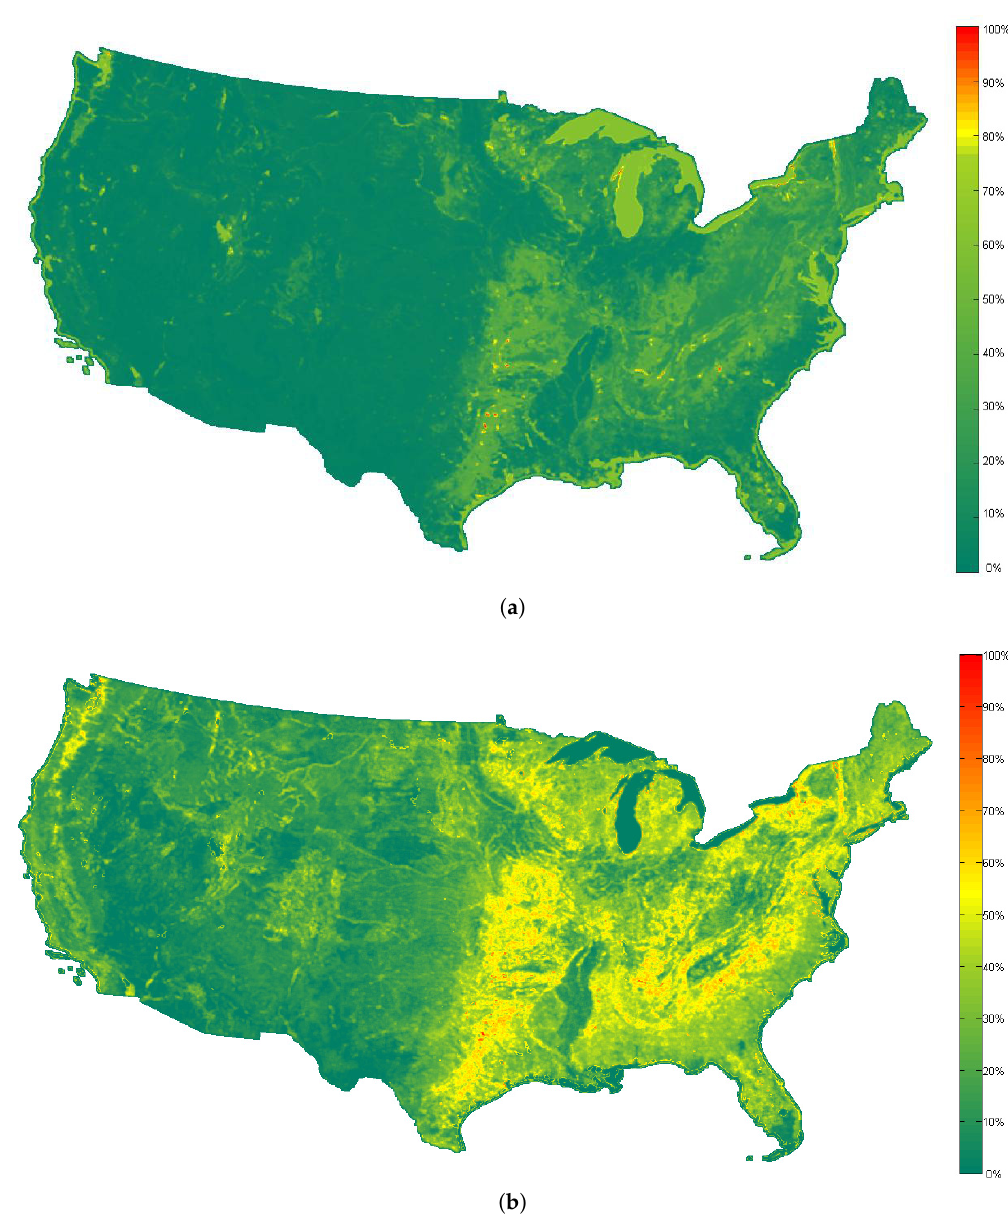
Figure 9. Similarity maps (with a resolution of 3 km) of reference scene I. ( a ) The proposed method; ( b ) The method proposed in